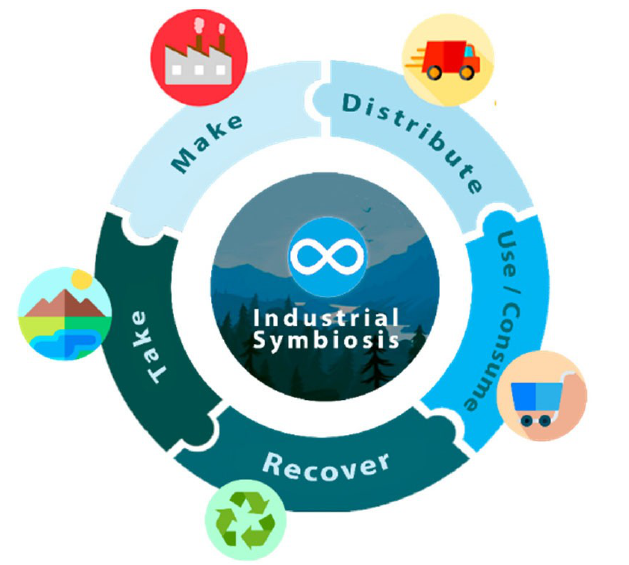
Figure 1. Circular economy fields of